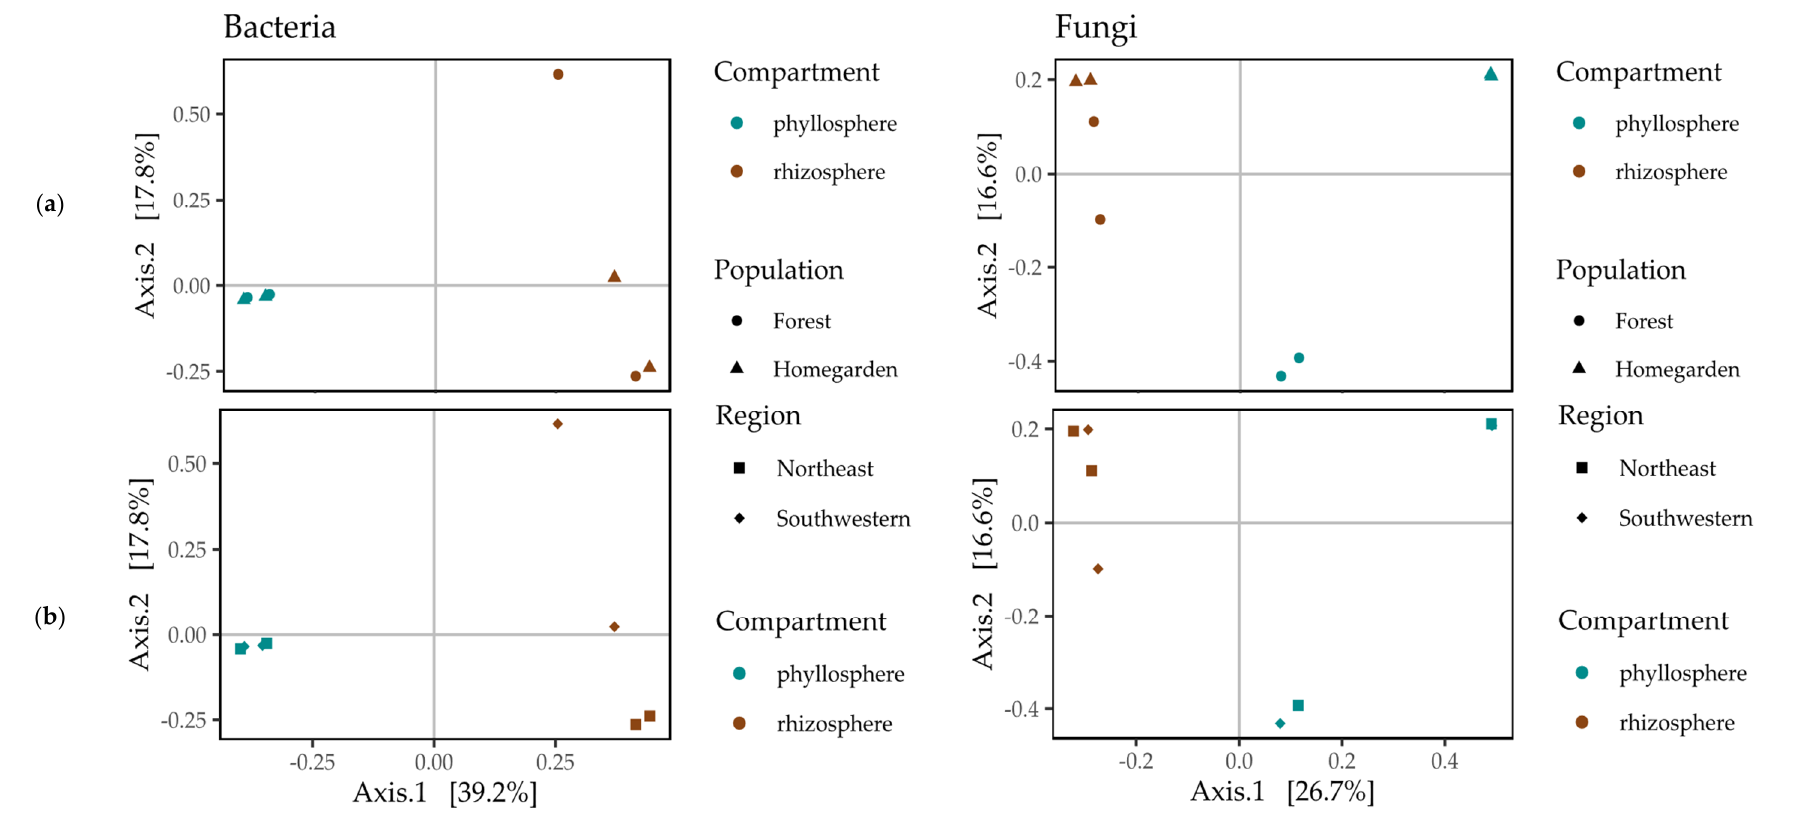
Figure 6. Principal component analysis of the microbiota communities from the phyllosphere and rhizosphere in ( a ) forest and homegarden populations of Cordia dodecandra in ( b ) the Northeast and Southwest regions of Yucatán.